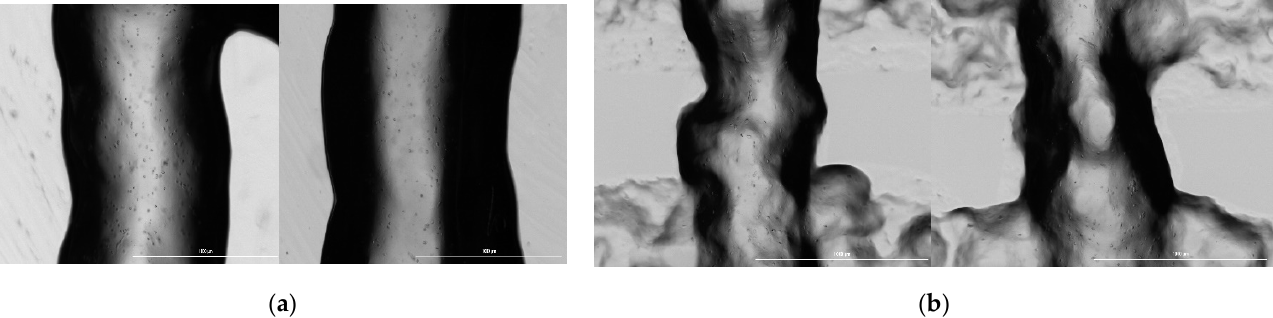
Figure 9. Brightfield images at 4× magnification of ( a ) 3/4 Alg/Gel and ( b ) 3/7 Alg/Gel filaments directly after extrusion. The scale bars depict 1000 μ m.